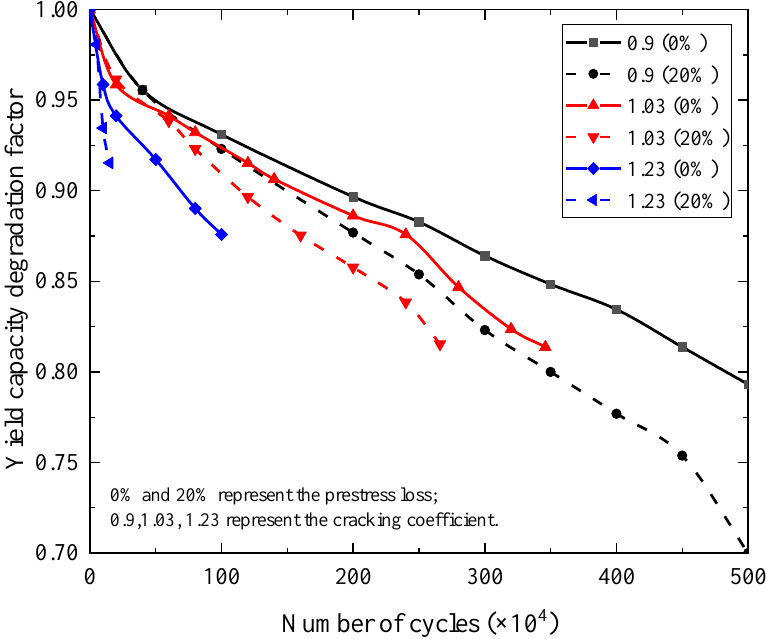
Figure 25. The effect of the fatigue load level and the prestress loss on the stiffness degradation of the beams.